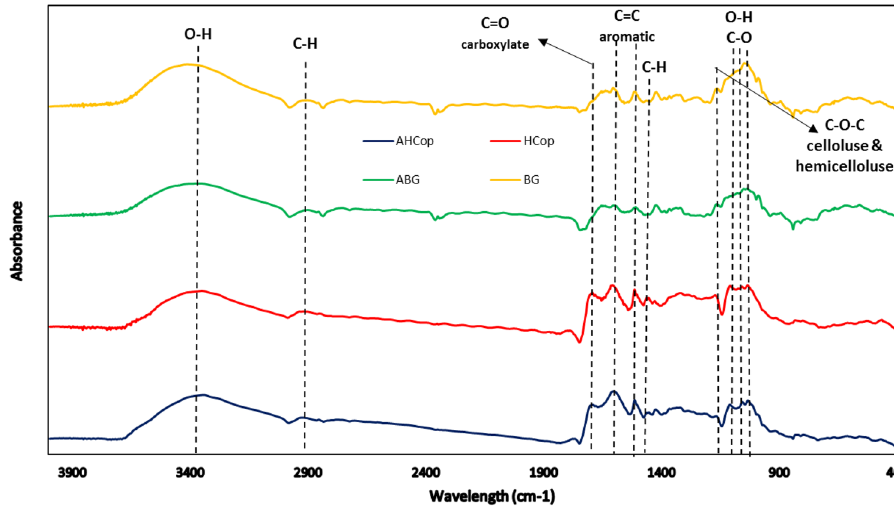
Figure 4. FTIR spectrum of BG, ABG, HCop and AHCop.